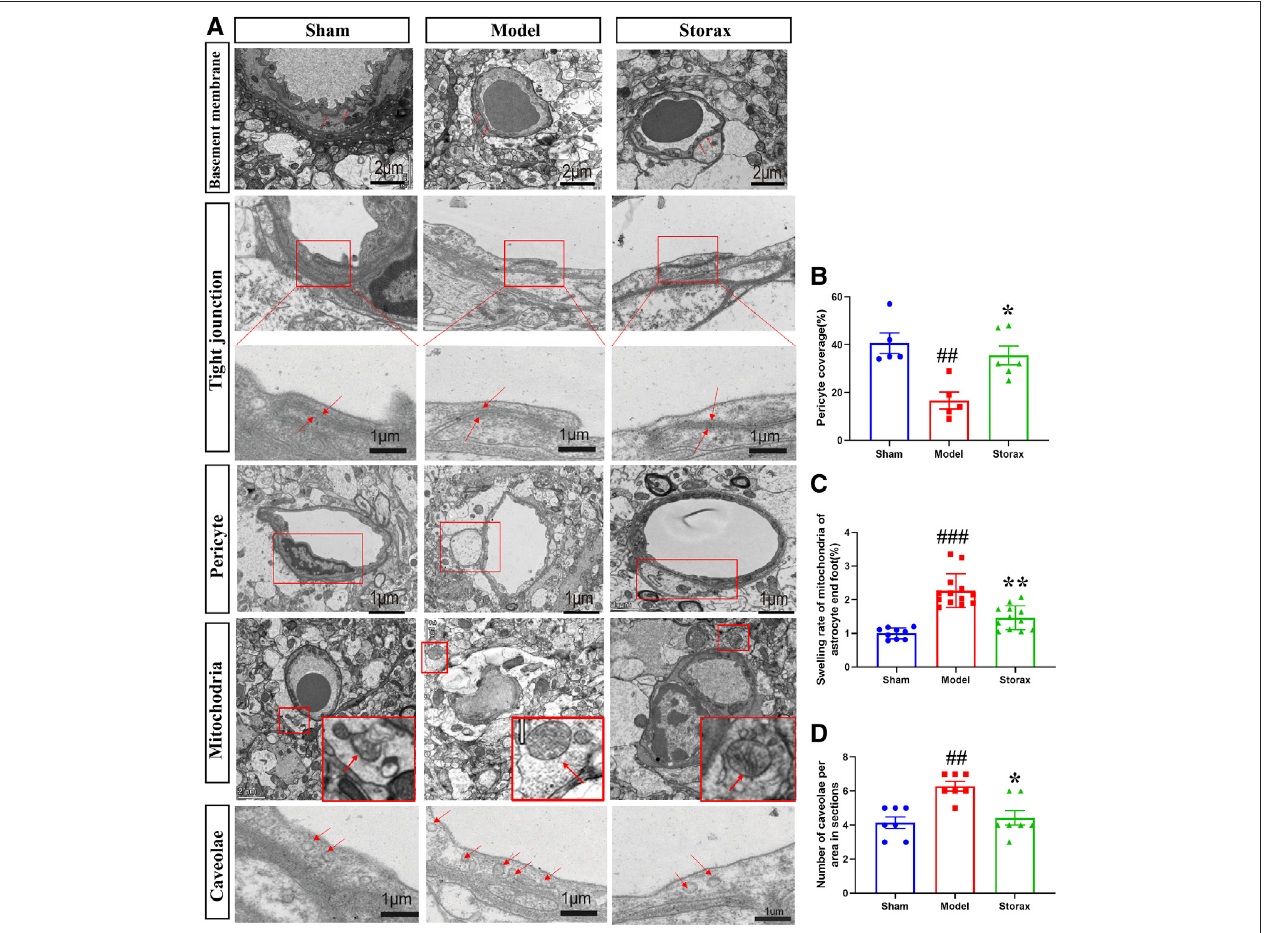
FIGURE3| Storaxinhibitscaveolae-mediatedtranscytosisandattenuatestheultrastructuraldisruptionofBBBat6 hafterstroke. (A) Representativeimagesofthe ultrastructure of basement membrane (BM), tight junctions (TJs), pericyte, astrocytic mitochondrial and caveolae in endothelial cells (ECs) under TEM observation at 6 h after stroke. (B – D) Quanti fi cation of the pericyte coverage, swelling rate of the astrocytic mitochondrial and the number of caveolae. Data were shown as the mean ± SEM. ## p < 0.01, ### p < 0.001 vs . Control group, * p < 0.05 vs . Storax group, n =